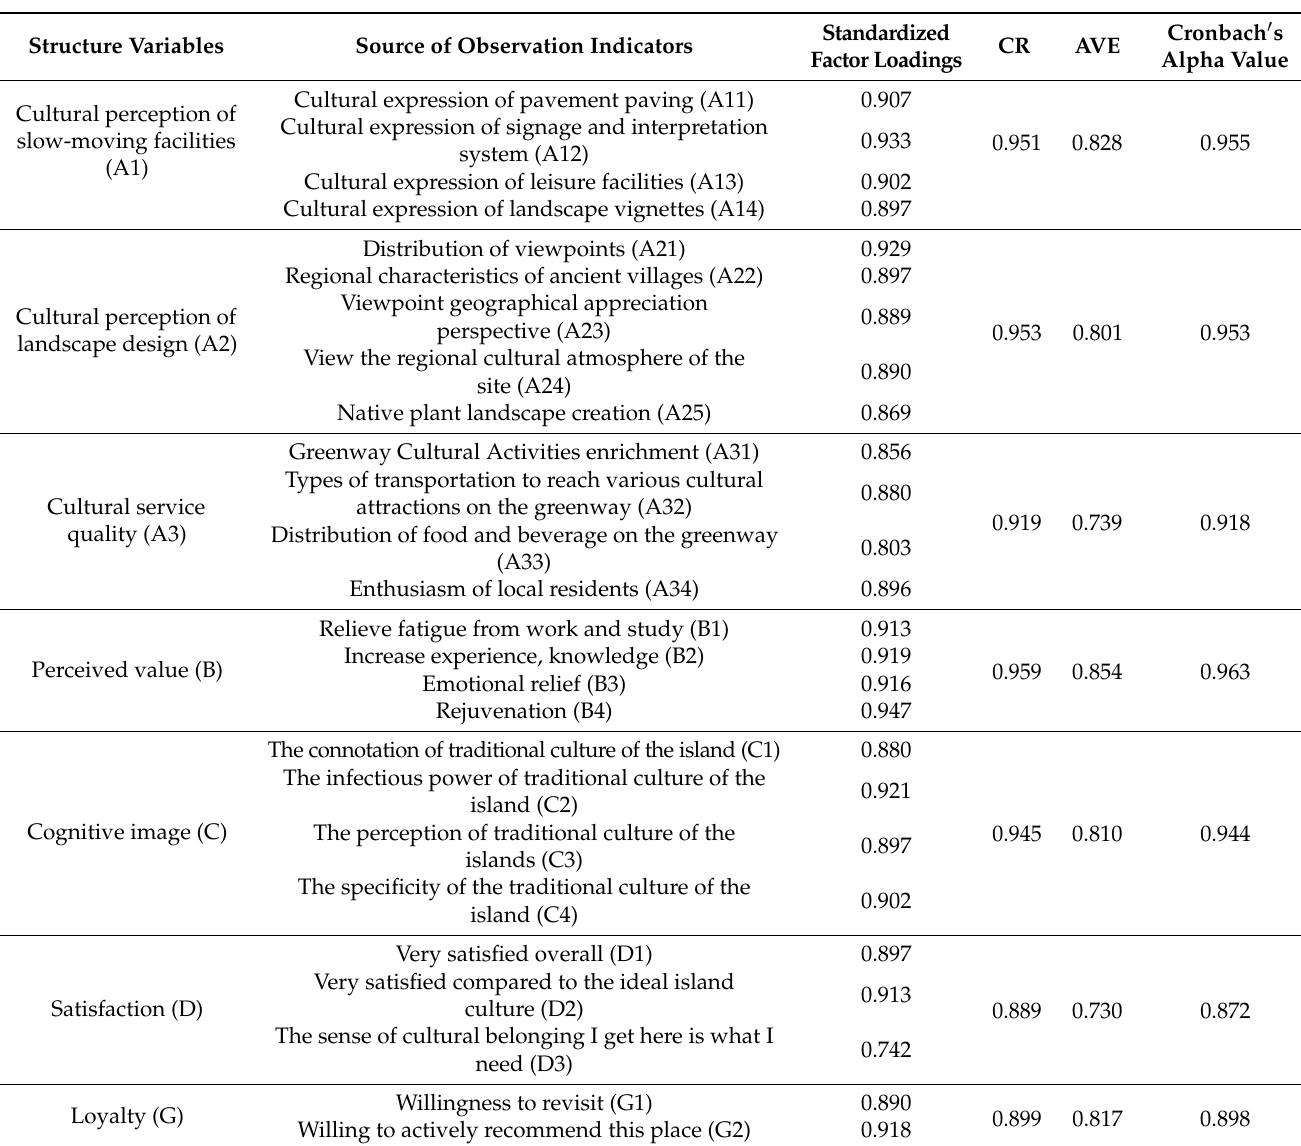
Table 8. Measurement scale question fit coefficients.